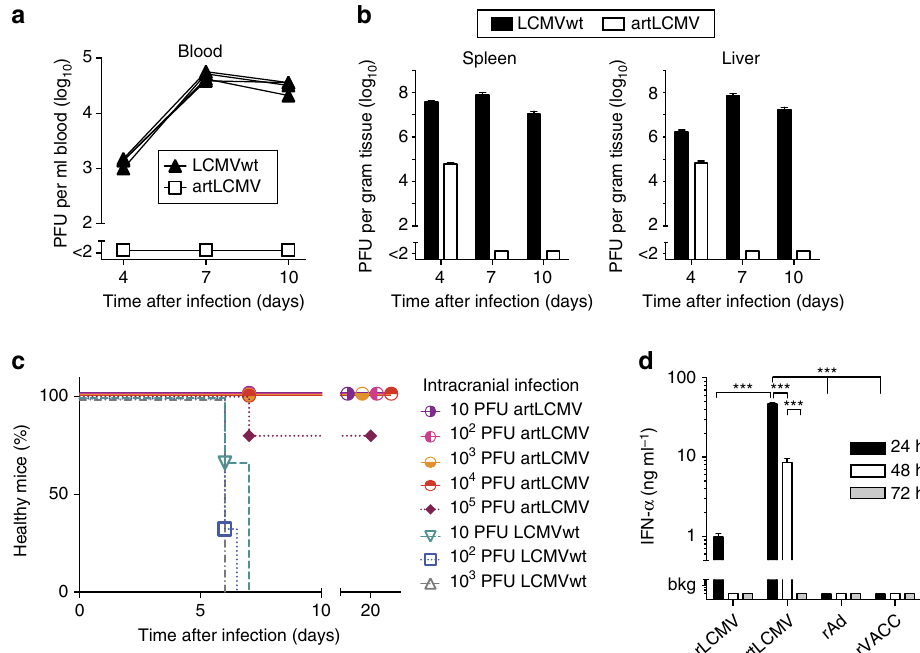
Figure 3 | artLCMV is attenuated in vivo and induces systemic type I interferon. ( a , b ) Viral loads in blood ( a ), spleen and liver ( b ) of C57BL/6 mice. Symbols and lines show individual mice (overlaid for artLCMV, a ), bars represent the mean þ s.e.m. ( b ) ( n ¼ 4). N ¼ 2. ( c ) Choriomeningitis incidence in i.c. infected mice. Terminally diseased animals were euthanized. ( n ¼ 3–5). ( d ) Serum IFN- a after artLCMV, rLCMV, rAd or rVACC immunization. Bars represent the mean þ s.e.m. of four mice. N ¼ 2. Data in d were analysed by two-way ANOVA with Bonferroni post hoc test. *** P o 0.001. NATURE COMMUNICATIONS|8:15327|DOI: